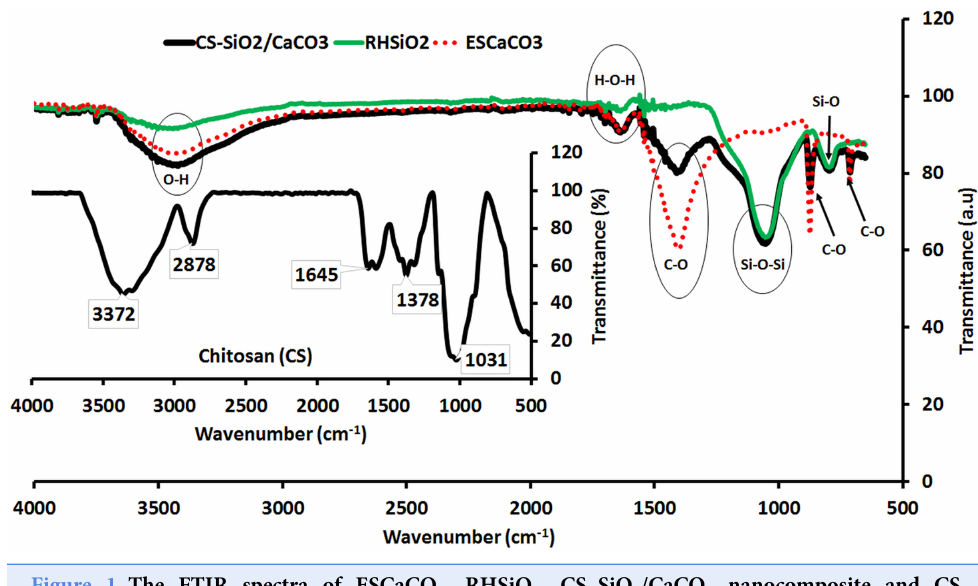
Figure 1 The FTIR spectra of ESCaCO 3 , RHSiO 2 , CS – SiO 2 /CaCO 3 nanocomposite and CS